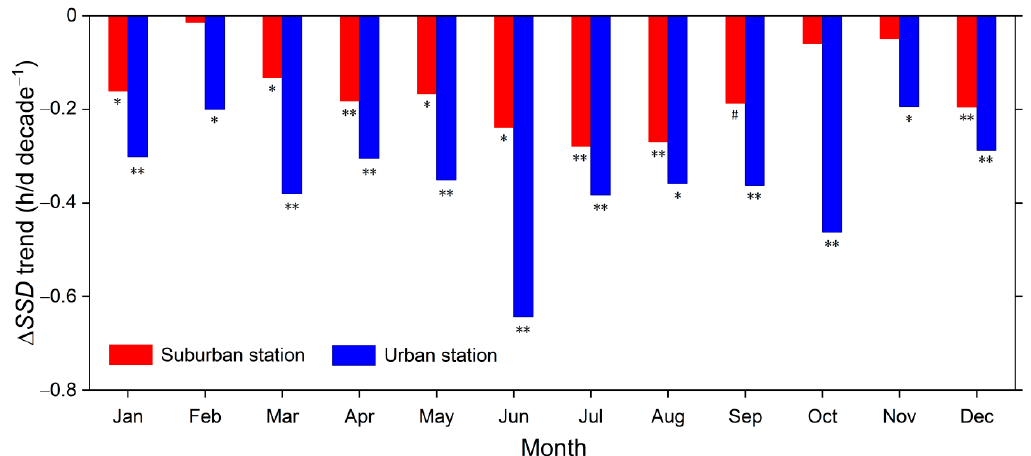
Figure 5. Urbanization effects on the trends of monthly mean sunshine duration ( ∆ SSD ) at suburban and urban stations from 1987 to 2016. #, *, and ** indicate that the trends are significant at the 0.10, 0.05, and 0.01 significance levels, respectively.